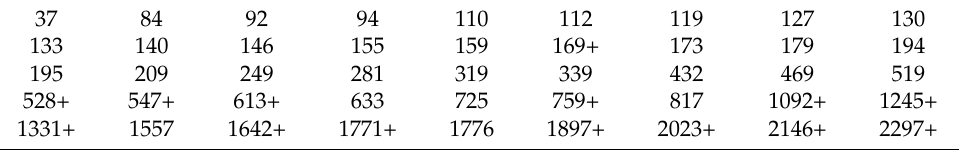
Table 2. Censored survival times from Arm B (Chemotherapy+Radiation) of the NCOG